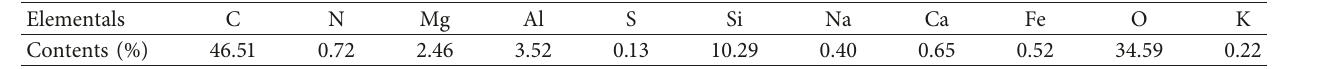
Table 1: Elemental composition of oil shale semicoke.